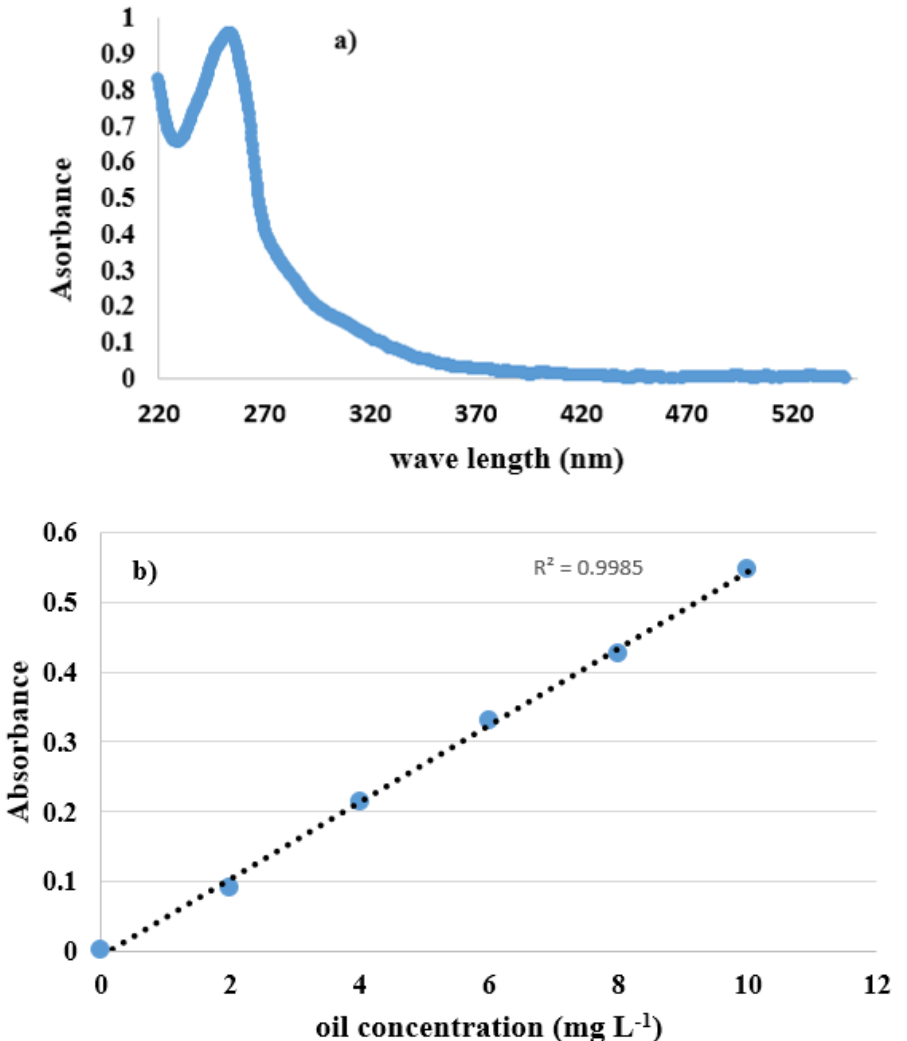
Figure 5. ( a ) UV-Vis absorption spectra ( b ) Calibration curve.